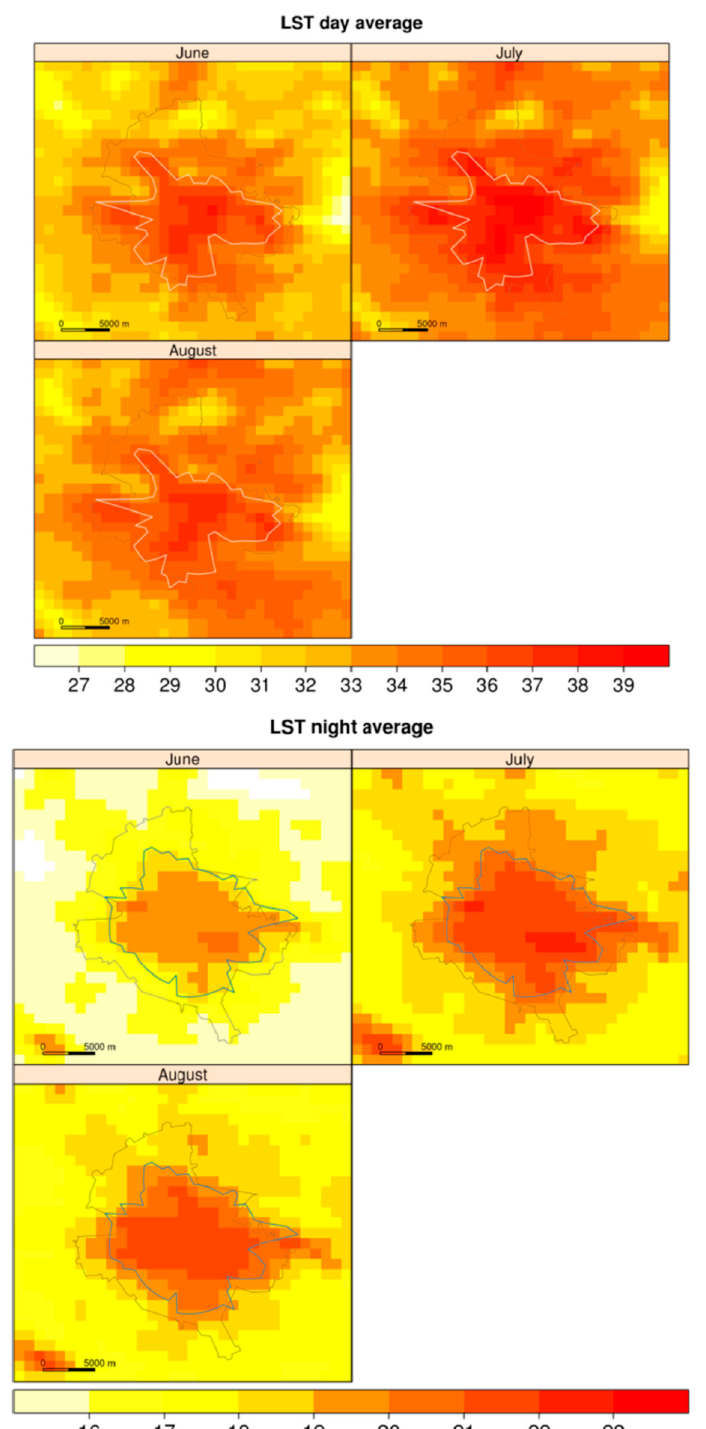
Figure 1. Average LST values and Bucharest’s UHI limit (white contour line for daytime and blue contour line for nighttime), as retrieved from MODIS images (2000–2012). The administrative limit is marked with a light grey line [71] (Material from: ‘Cheval, S.; Dumitrescu, A. The summer surface urban heat island of Bucharest (Romania) retrieved from MODIS images, Theor. Appl. Climatol., published [2015],.[Springer]’.)